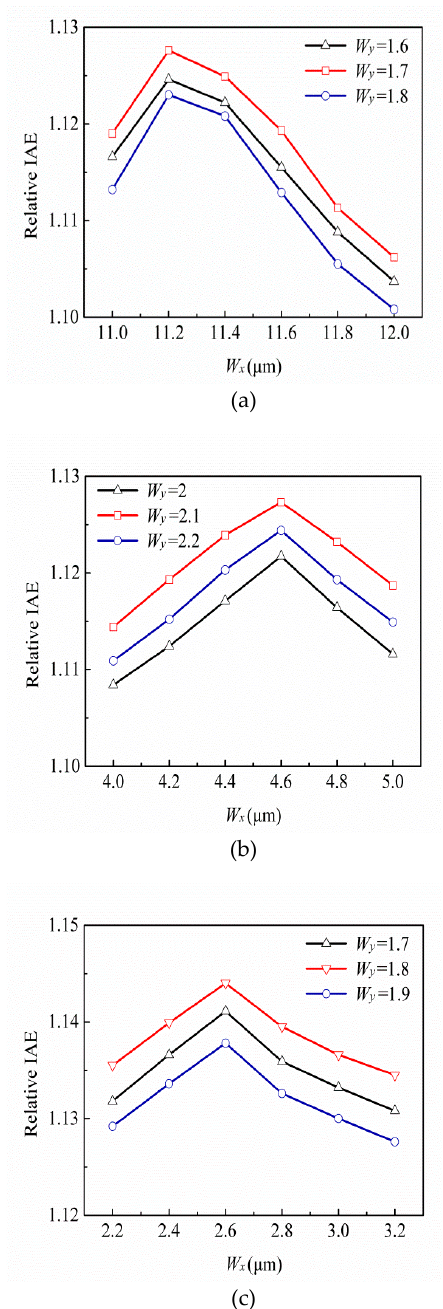
Figure 4. Variances of the relative infrared absorption e ffi ciencies (IAEs) with di ff erent W x and W y for the thermopiles with RC-type ESCSs at the target temperature 75 ◦ , ( a ) one RC, ( b ) two RCs, and ( c ) three